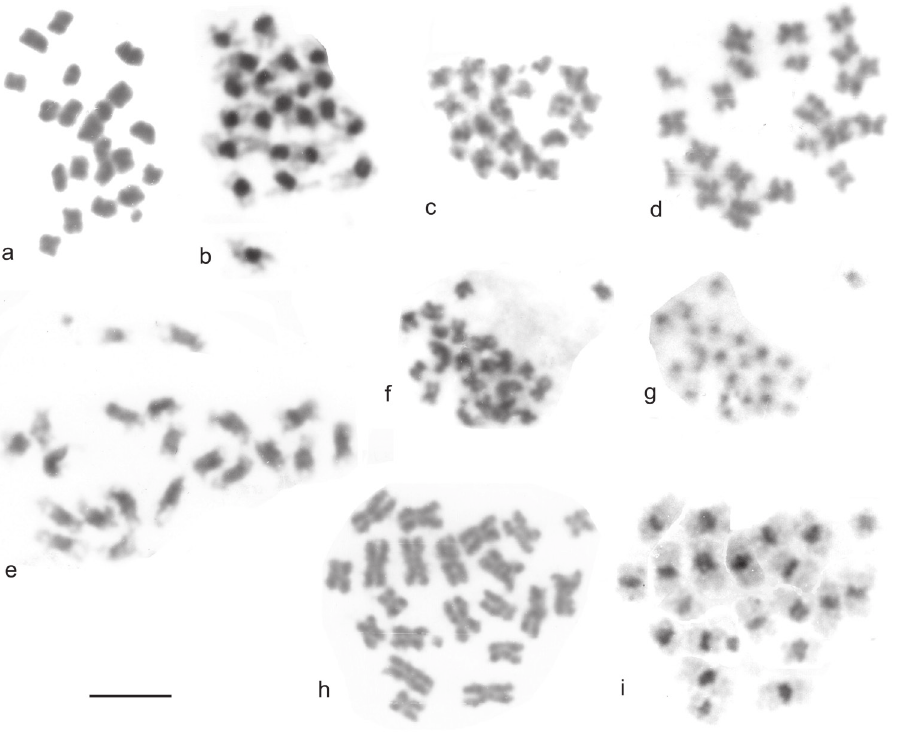
gut cell a plain b C-banded c , d Espanoliella luquei , mid-gut cells, plain c ♂ d ♀ e Fresnedaella lucius , testis, C-banded f , g Notidocharis uhagoni , ♂ , mid-gut cell f plain g the same nucleus C-banded h , i Quaestus pasensis , ♂ , mid-gut cell h plain i the same nucleus C-banded. Scale bar = 5